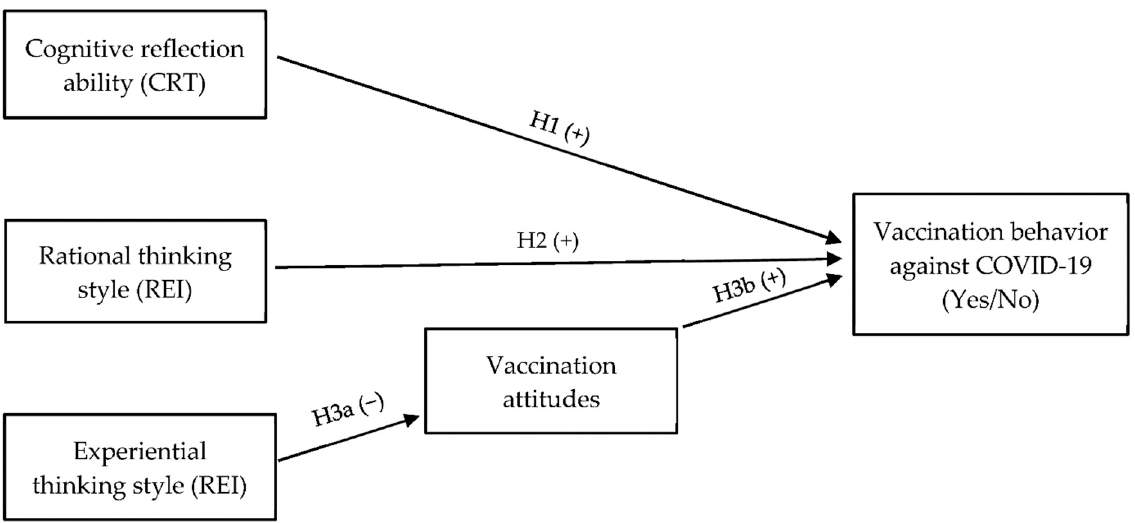
Figure 1. The hypothesized direct and indirect prediction